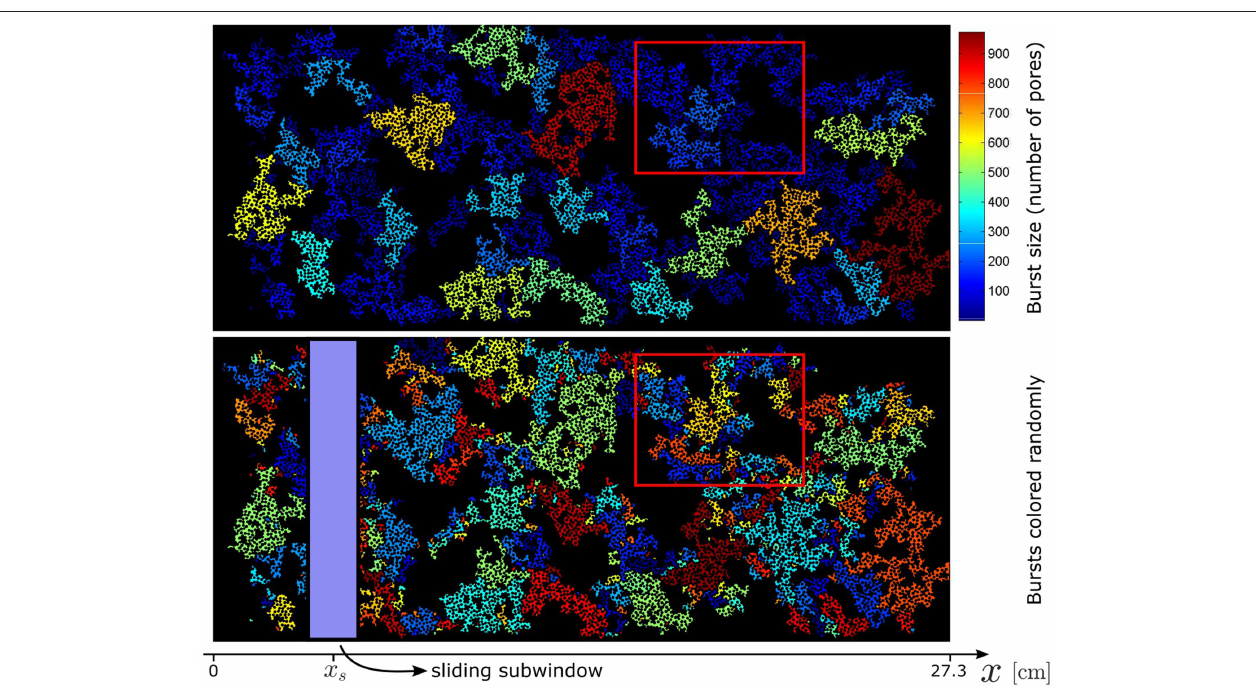
FIGURE 5 | Invasion until final saturation for the CIP boundary condition, using the same model shown in Figure 3 . (Top) Individual bursts color coded by their size, computed dividing the burst area by the characteristic pore area of 100 pixels 3 mm. (Bottom) Individual bursts color coded randomly, to allow the visualization of ≈ separate bursts of similar size. Notice in particular that the vast blue areas in the top image are indeed formed by a set of smaller bursts, as can be seen in the detail (red rectangle). The sliding subwindow centered at x s is used in connection with the spatial distribution of bursts. In both images, only bursts with centroids lying in the central 90 % of the model’s length are shown. Adapted from Moura et al. [ 23] under the Creative Commons CCBY